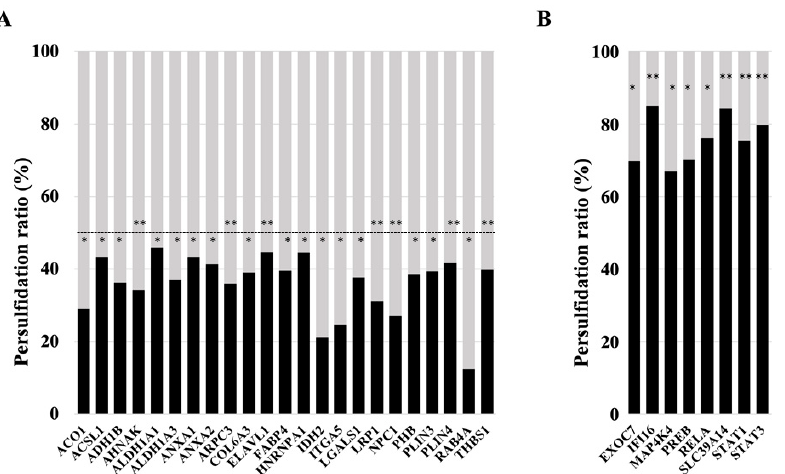
Figure 3. Rate of persulfidation of relevant proteins involved in adipocyte function and the main- tenance of adipogenesis. Level of protein persulfidation in siRNA_MIX samples (black boxes, in percentage) compare to the level in control samples (grey boxes). ( A ) ACO1, Cytoplasmic aconitate hydratase; ACSL1, Long-chain-fatty-acid—CoA ligase 1; ADH1B, All-trans-retinol dehydrogenase [NAD(+)] ADH1B; AHNAK, Neuroblast differentiation-associated protein AHNAK; ALDH1A1, Retinal dehydrogenase 1; ALDH1A3, Aldehyde dehydrogenase family 1 member A3; ANXA1, An- nexin A1; ANXA2, Annexin A2; ARPC3, Actin-related protein 2/3 complex subunit 3; COL6A3, Col- lagen alpha-3(VI) chain; ELAVL1, ELAV-like protein 1; FABP4, Fatty acid-binding protein adipo-